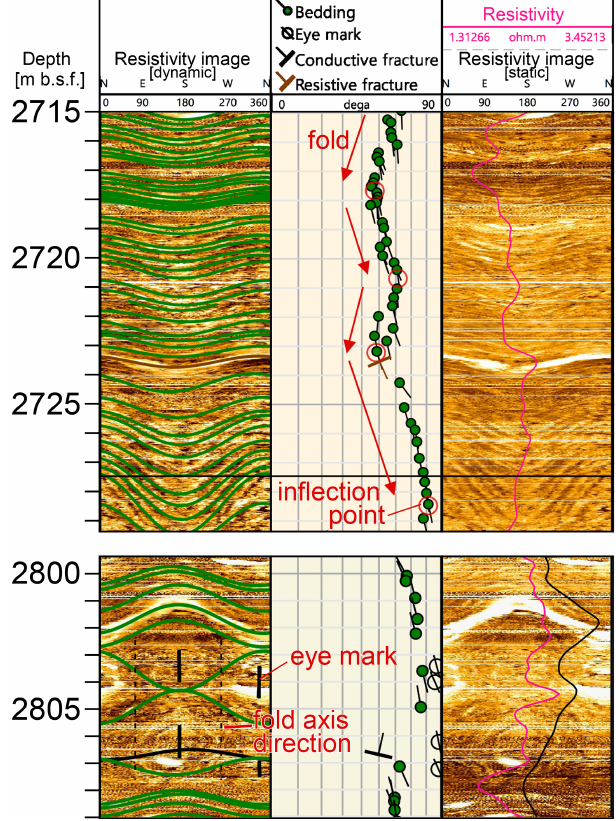
Figure 1. Example of fold appearance in a borehole wall image. Bedding planar interpretation, fold inflexion points, and eye marks are interpreted in the electrical resistivity image of the interior of the accretionary complex that was acquired from the IODP (Inte- grated Ocean Drilling Program) Expedition 348 (Tobin et al., 2015). Green lines in the dynamic resistivity image are fitted using a bed- ding plane, and its orientations are plotted in tadpole plot. The pink line in the static image is the shallow resistivity value. The folds ap- pear as a systematic increase or decrease in the dip of the bedding. The eye, the hinge of the fold, can also be observed. The orientation of the fold axis is orthogonal to the eye direction and is indicated by the dotted line in the lower